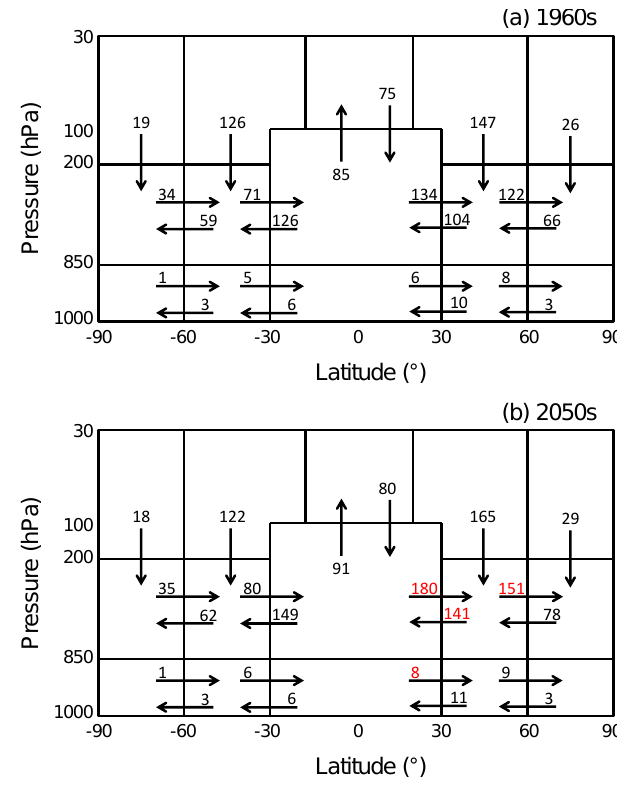
Figure 6. Changes between the 2000s and 2020s decades (2020s minus 2000s) in the REF-C2 simulation at 500hPa for: (a) NO x ; (b) NMVOCs + CO; (c) ozone. Shading indicates that the differ- ence is statistically significant at the 95% level of confidence.